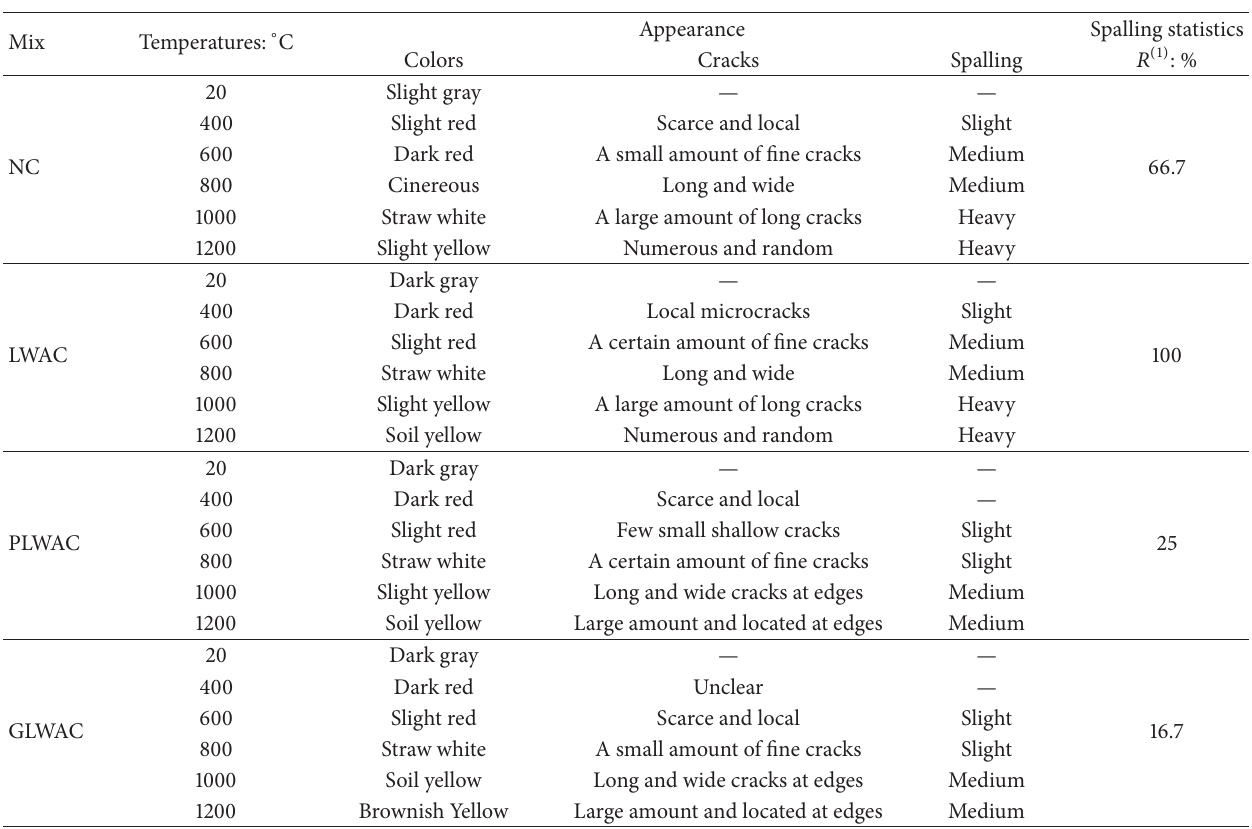
Table 4: Appearance and spalling statistics of the concrete specimens after exposure to elevated